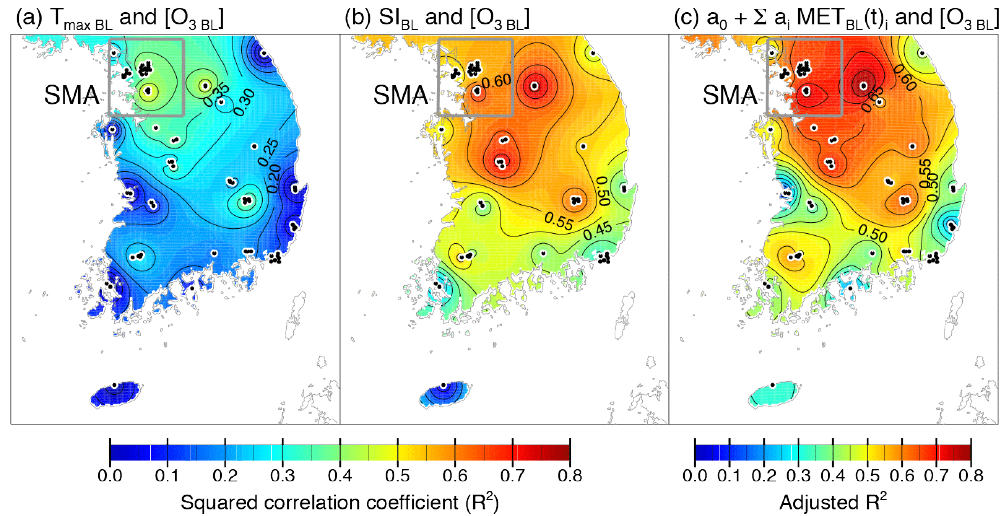
Figure 5. Spatial distributions of R 2 between baselines of O 38h ([O 3BL ]) and (a) daily maximum temperature ( T maxBL ) and (b) surface insolation (SI BL ) . Black dots represent 72 air quality monitoring sites of NIER. (c) Spatial distribution of adjusted R 2 between [O 3BL ] and combined meteorological effects ( a 0 + P i a i MET BL (t) i ) .